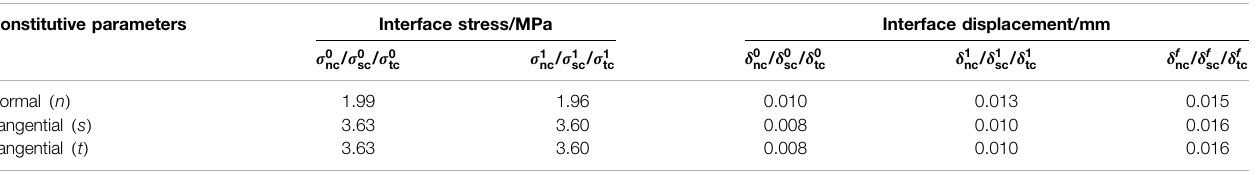
TABLE 2 | Constitutive parameters of the toughened epoxy bonding